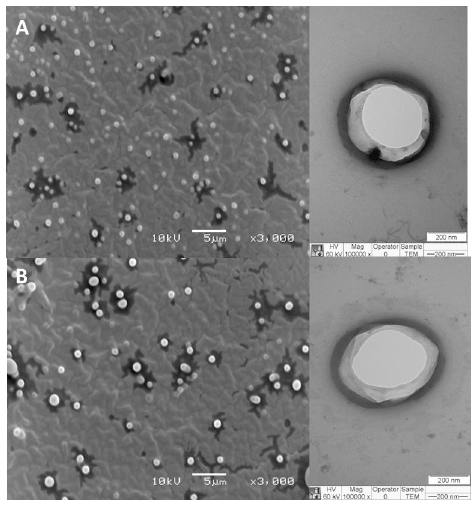
Figure 2. FE-SEM (left) and TEM (right) images of PCT@LIP ( A ) as control and PCT@LIP/NOR ( B ) containing 0.2% NOR ( w / v ) formulations. The used magnifications are displayed in the images.